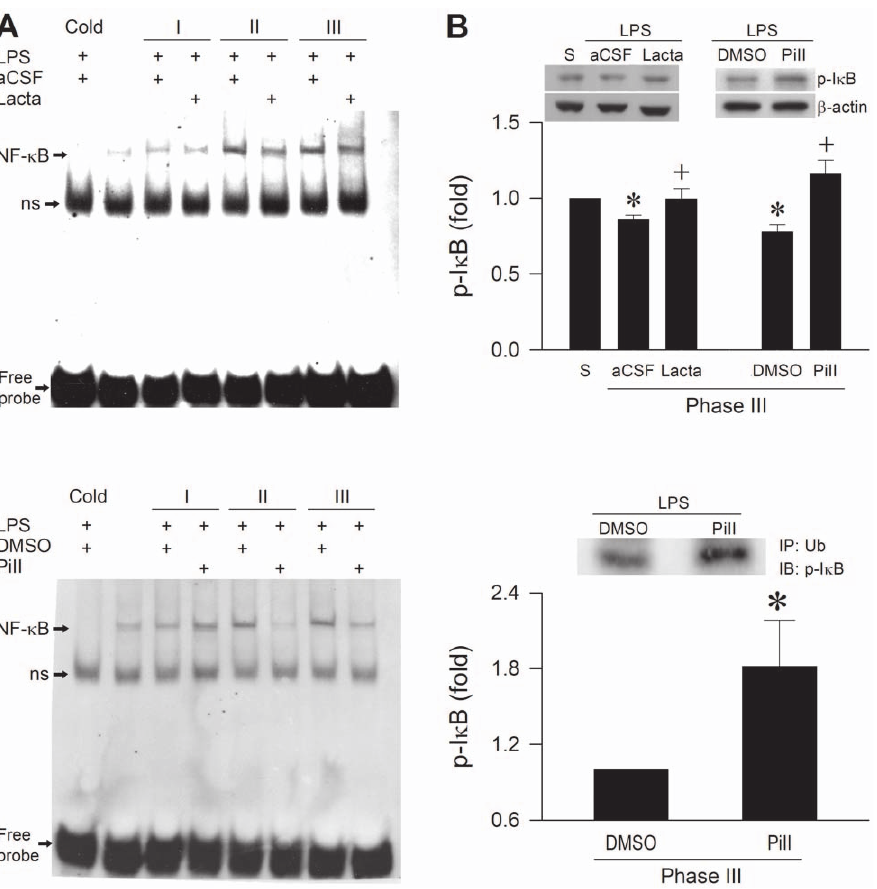
Figure 3. UPS is engaged in the synthesis of NOS II via transcriptional activation of NF- k B in RVLM. (A) Representative gels depicting NF- k B DNA binding detected by EMSA in nuclear extracts from ventrolateral medulla of rats that received pretreatment by microinjection bilaterally into RVLM of lactacystin (Lacta; 1 nmol) or aCSF (upper diagram), or proteasome inhibitor II (PiII; 1 nmol) or DMSO (lower diagram), followed by IV administration of LPS (15 mg kg 2 1 ). A competitive assay with the addition of 100-fold of unlabeled NF- k B oligonucleotide was used to control for non-specific binding (Cold). In both gels, ns denotes non-specific binding. (B) Illustrative gels or summary of fold changes against sham-controls of phosphorylated I k B a (p-I k B a ) in cytosolic proteins detected by Western blot analysis (upper diagram) or immunoblot analysis of p-I k B a immunoprecipitated by an anti-ubiquitin (Ub) antiserum (lower diagram) during Phase III experimental endotoxemia in rats that received those treatments depicted in (A). Values are mean 6 SEM of duplicate analyses on individual samples obtained from 5–6 animals per experimental group. * P , 0.05 versus sham-control group, and + P , 0.05 versus aCSF + LPS or DMSO + LPS group in the Scheffe´ multiple-range test.